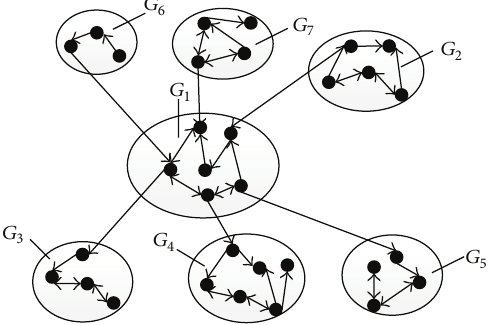
Figure 5: Multiple inputs and multiple